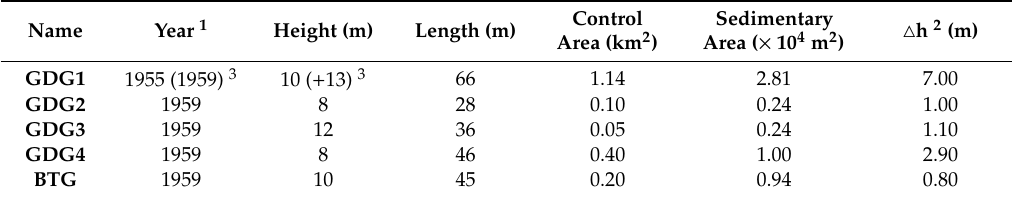
Table 2. Characteristics of the 5 check dams in GDG